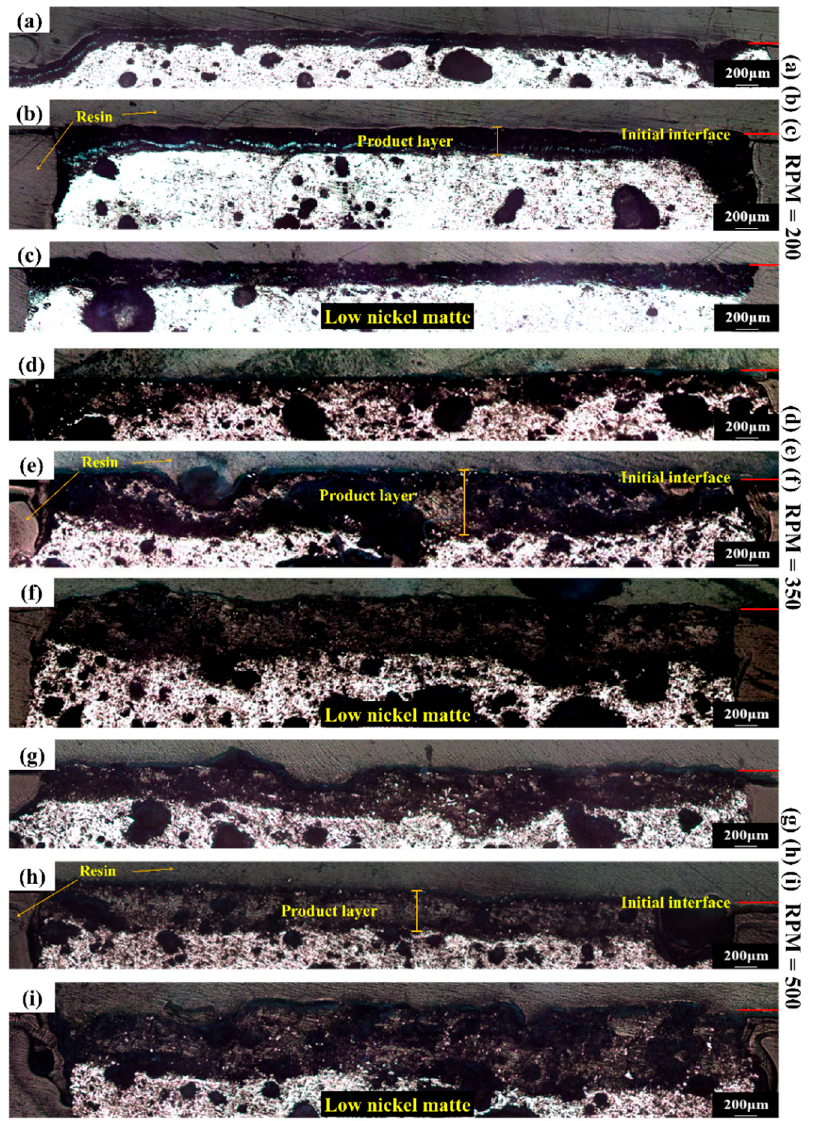
Figure 5. ( a – c ) OM images of the low-nickel matte at 200 RPM after 1, 2, and 3 h leaching, respectively; ( d – f ) OM images of the low-nickel matte at 350 RPM after 1, 2, and 3 h leaching, respectively; ( g – i ) OM images of the low-nickel matte at 500 RPM after 1, 2, and 3 h leaching, respectively.